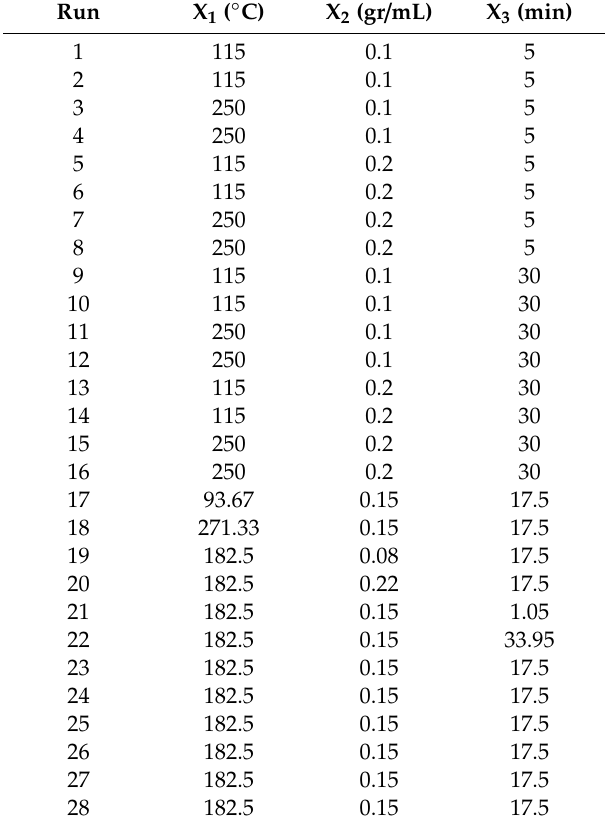
Table 1. Central Composite Design (CCD) for the extraction of essential oils from A. malaccensis wood, by way of the Subcritical Water (SCW)